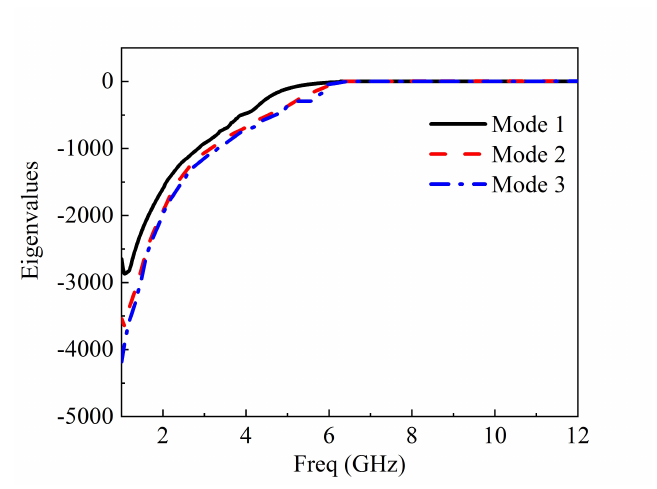
Figure 17. Eigenvalues for three modes at 7 GHz.